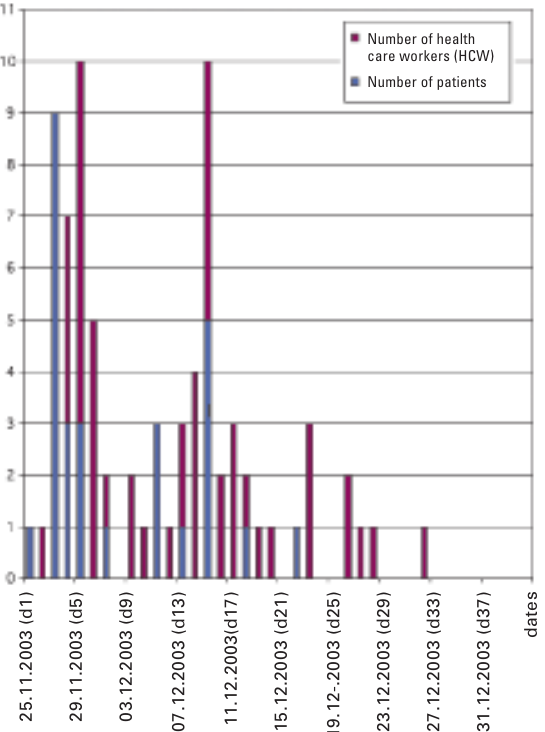
Norovirus-Outbreak 25.11.2003–31.12. 2003: Epidemic curve shows two peaks of case incidence. First peak in building 1, second peak in build- ing 2. Total number of persons with gastroenteritis: